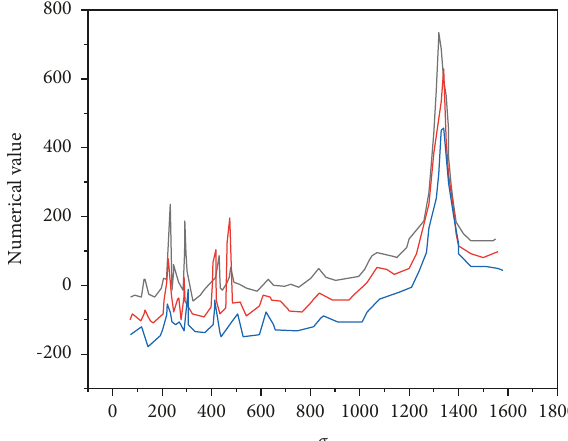
Figure 4: Raman spectra of chromogenic minerals of Nanhong agate.